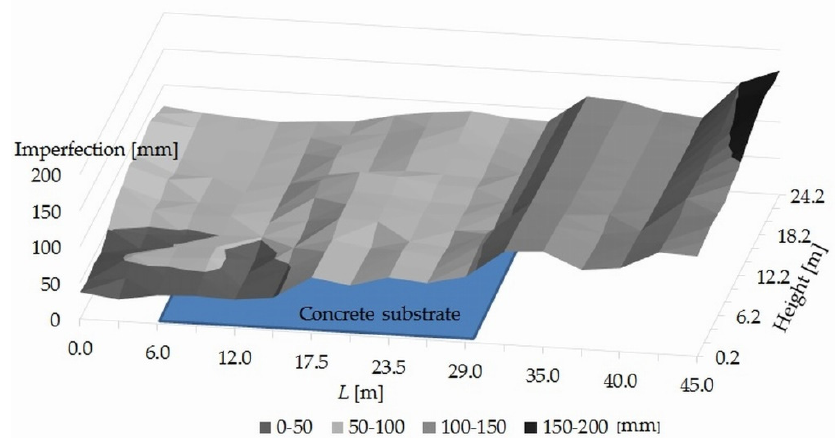
Figure 3. Distribution of imperfections on the outer plane of the L12 scaffolding.